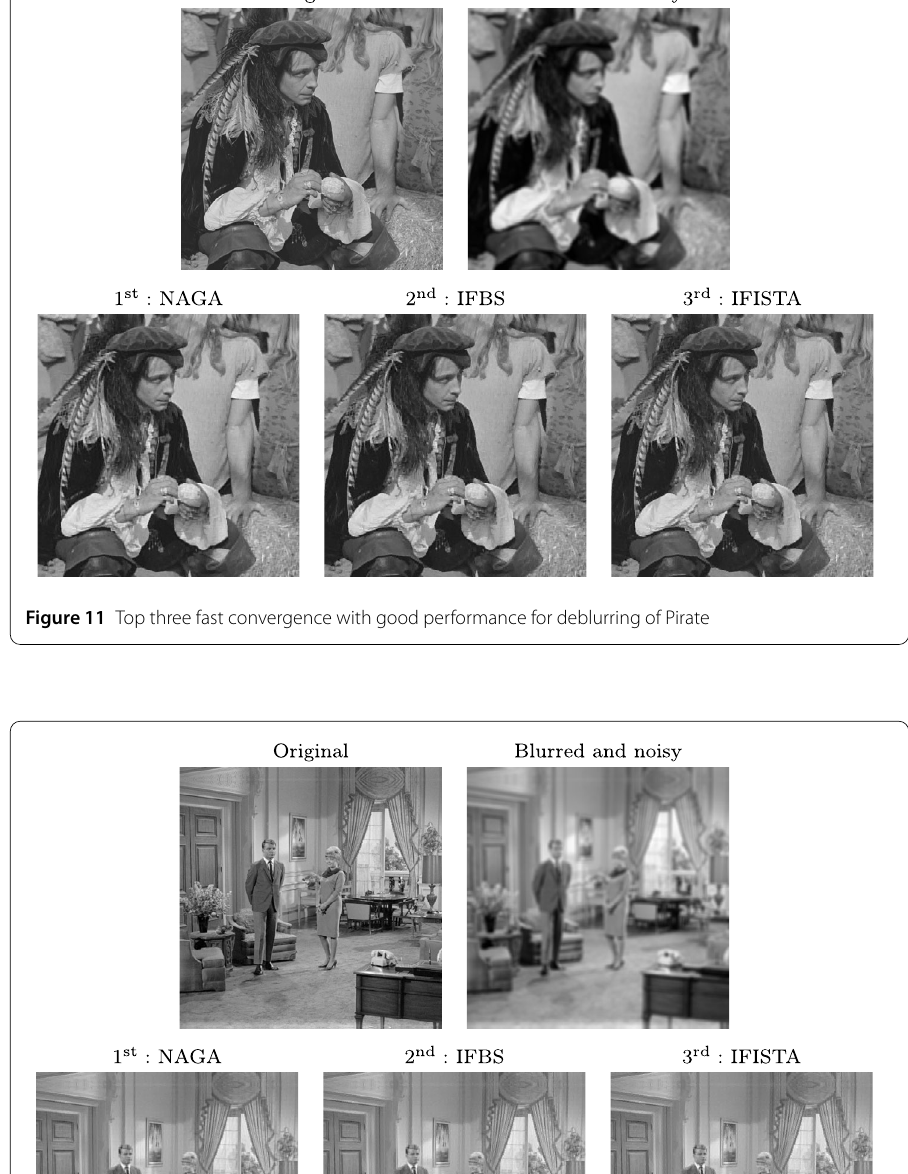
1. For looking at the fast processing with high performance for compared image deblurring, IFISTA, IFBS, and FISTA are in the 1 st , 2 nd , and 3 rd place, respectively, and all are better than FBMWA, FBMMMA, NAGA, and